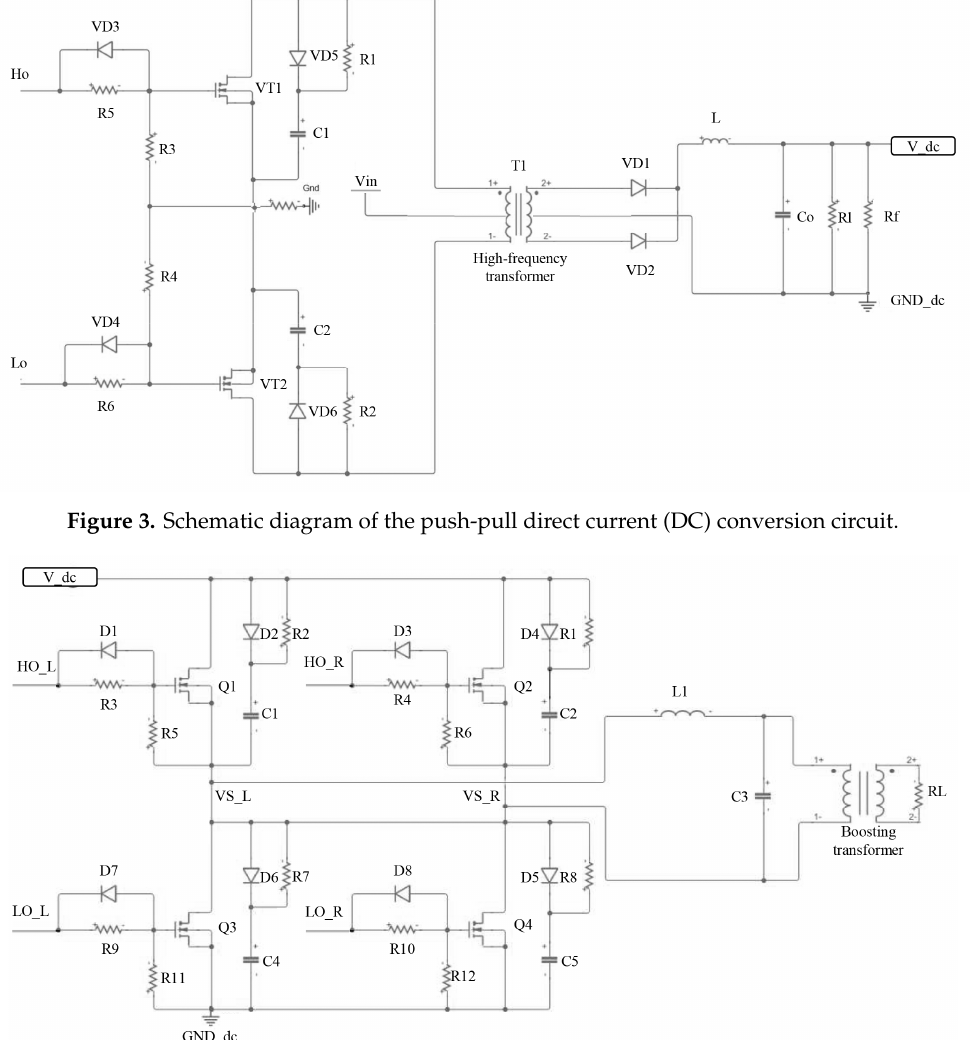
Figure 3 . Schematic diagram of the push-pull direct current (DC) conversion circuit.